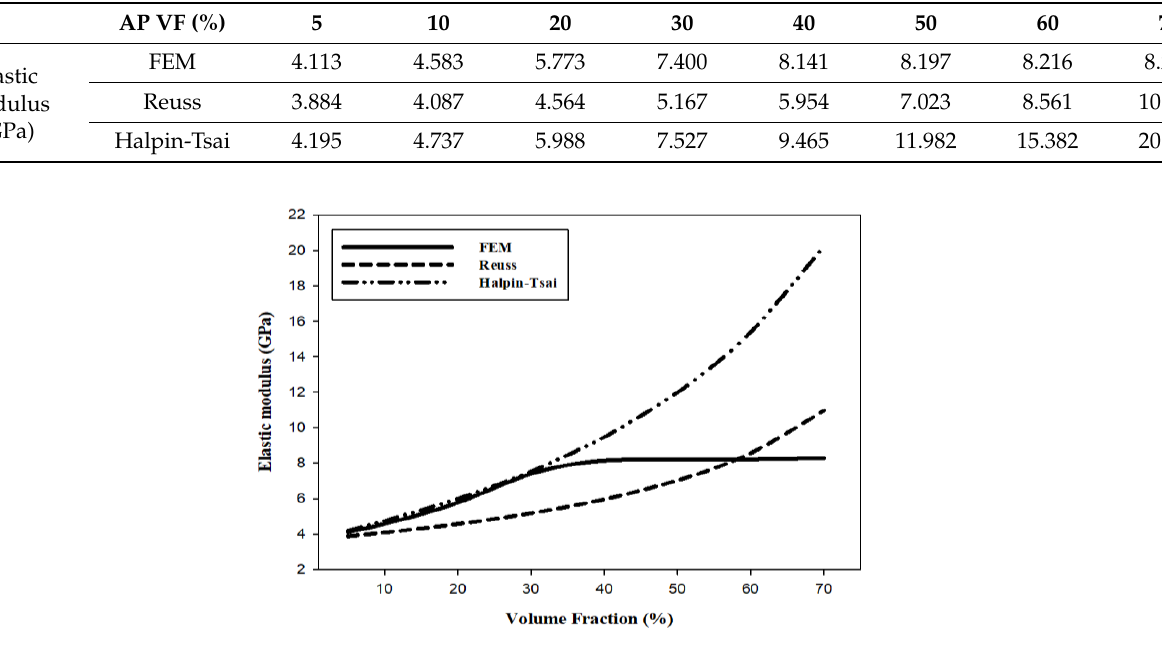
Figure 5. Elastic modulus predictions as a function of AP VF.